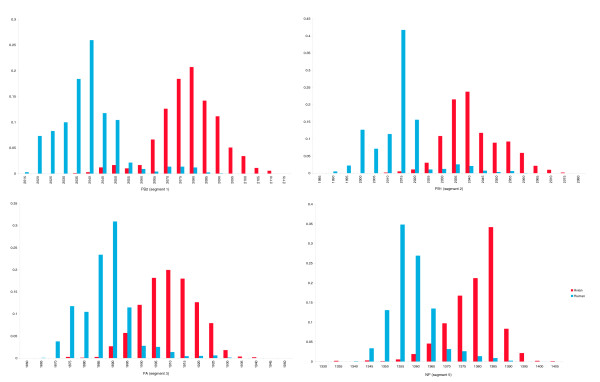
Potential hydrogen bond distribution (per segment) at all degenerate codon positions in human and avian influenza A strains. The x-axis is the number of potential hydrogen bonds per segment, while the y-axis represents the relative frequency.